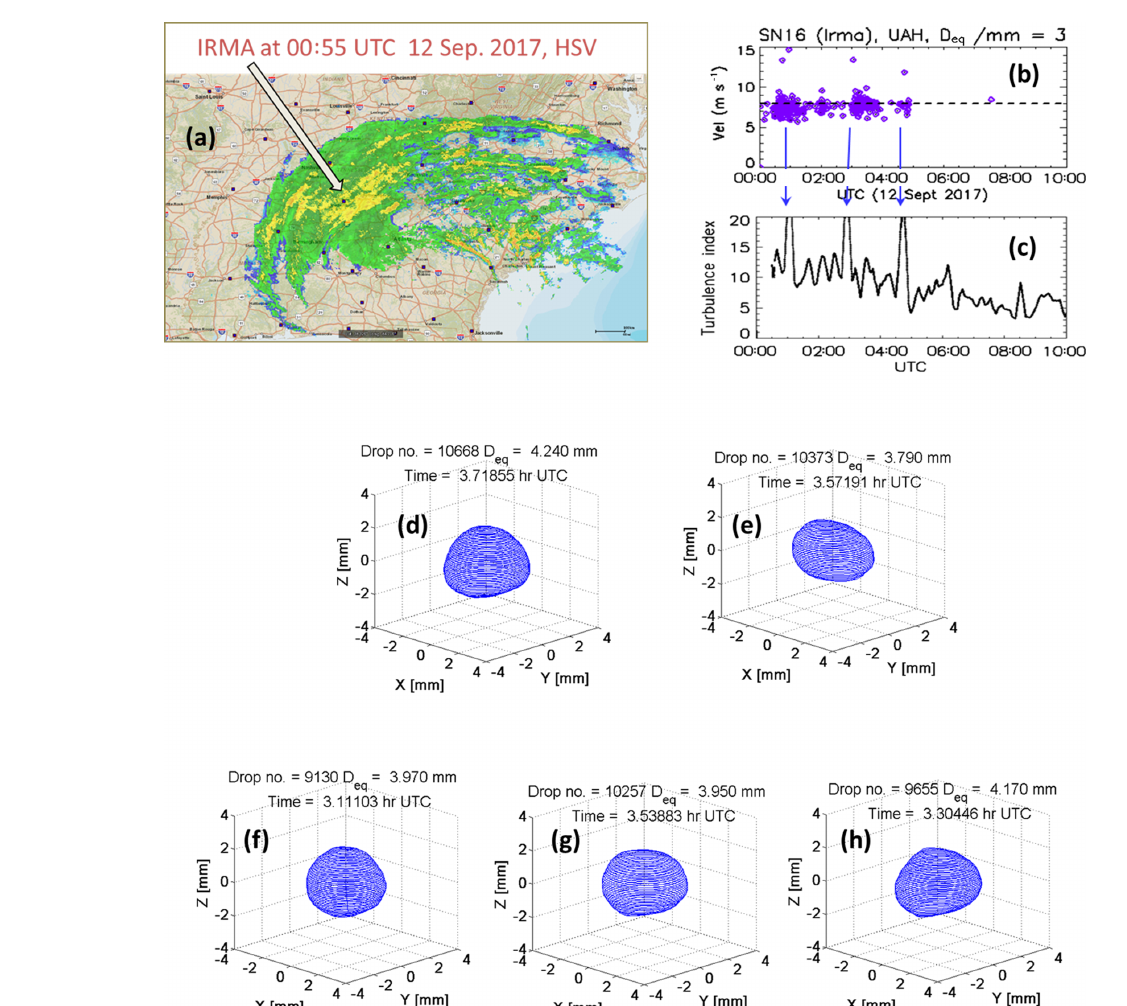
Figure 3. (a) Composite radar reflectivity image of Category-1 Hurricane Irma over Huntsville at 00:55UTC on 12 September 2017. The arrow marks the instrument site; (b) fall velocities of 3mm drops as UTC; (c) turbulence index, E , determined from the wind-sensor data (the blue arrows connect high E values with reduced fall velocities; (d) to (h) show examples of 4mm ( ± 0 . 25mm) drops undergoing mixed-mode, asymmetric drop